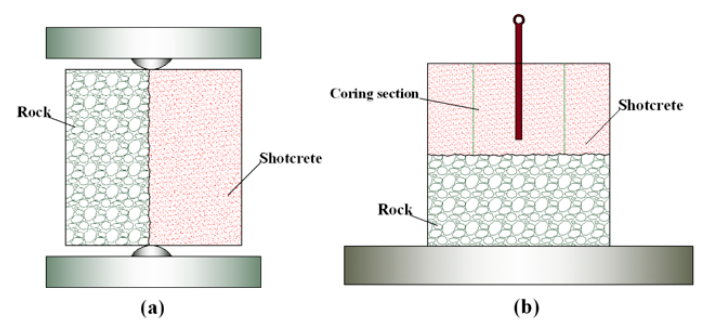
Figure 12. Schematic diagram of bond strength test: ( a ) splitting method and ( b ) core drilling and drawing method.